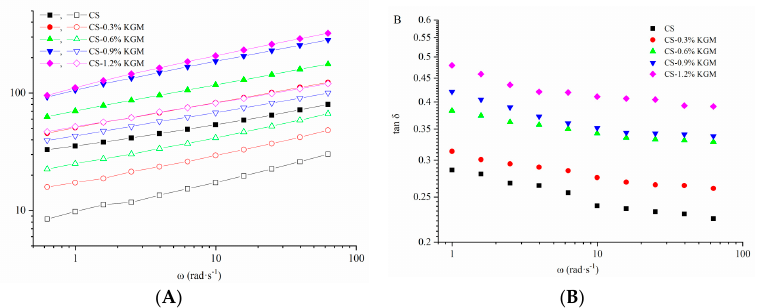
Figure 2. Curves of dynamic modylus ( A ) and tan δ ( B ) with angular frequency of CS/KGM